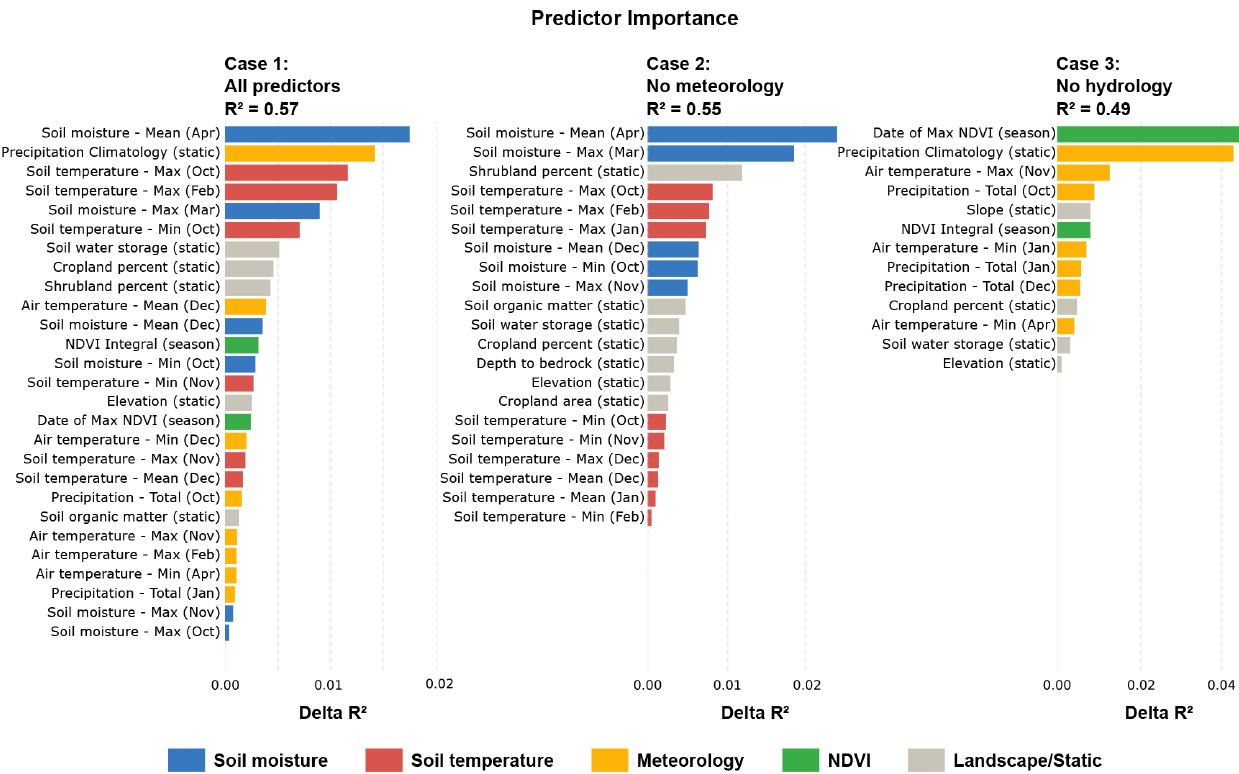
Figure 3. The most important predictors for maize yield at the district scale. The predictors were selected and ranked via recursive feature elimination, with the importance rank shown in terms of delta R 2 . Results are shown for case 1 (considering all the variables), case 2 (without precipitation and air temperature predictors), and case 3 (without soil moisture and soil temperature predictors). Each color represents different categories of predictors